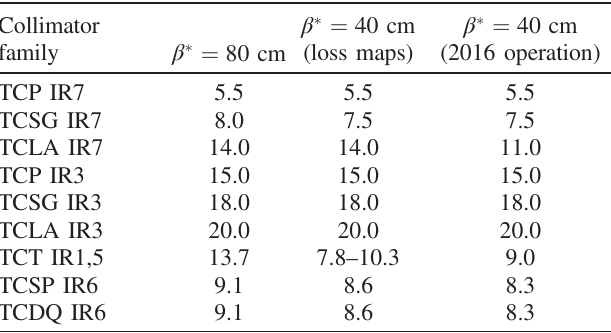
TABLE I. Collimator half gaps used during the tests described in this article, given in units of beam standard deviation σ , assuming the nominal β -function and a normalized emittance of 3 . 5 μ m. The settings at β (cid:1) ¼ 80 cm are the standard settings during physics operation in 2015, which were also used during the loss-map tests. At β (cid:1) ¼ 40 cm the settings used in the 2015 loss-map test and the 2016 operational settings are both shown. The latter were used during the TCT closure test, discussed in Sec. VI.